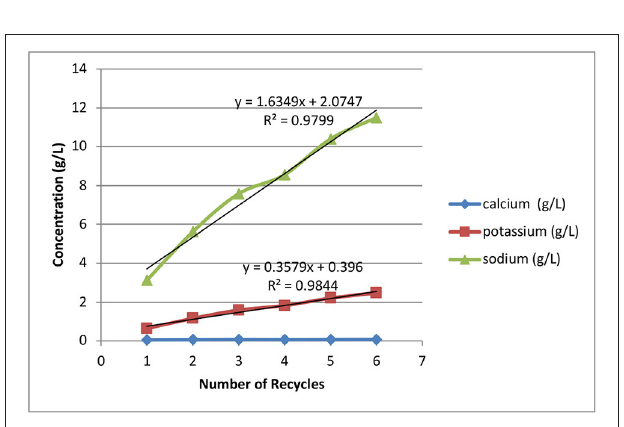
FIGURE 6 | Effects of weak black liquor recycling on the accumulation of sugars and acetic acid in the recycle